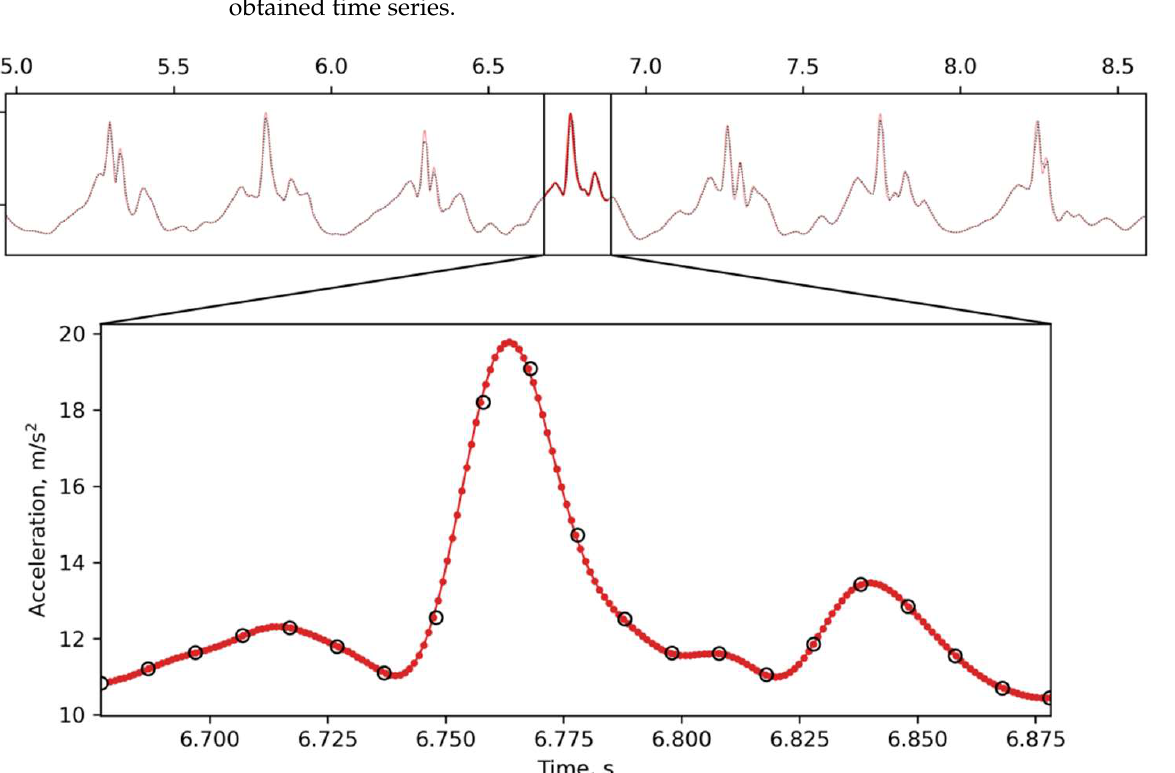
Figure 1. Up-sampling of a periodic signal obtained during walking. The black open circles on the bottom panel correspond to the real data sampled at a frequency of 100 Hz. The red points are new data points reconstructed with up-sampling. The red curve is a continuous signal passing through all the circles.